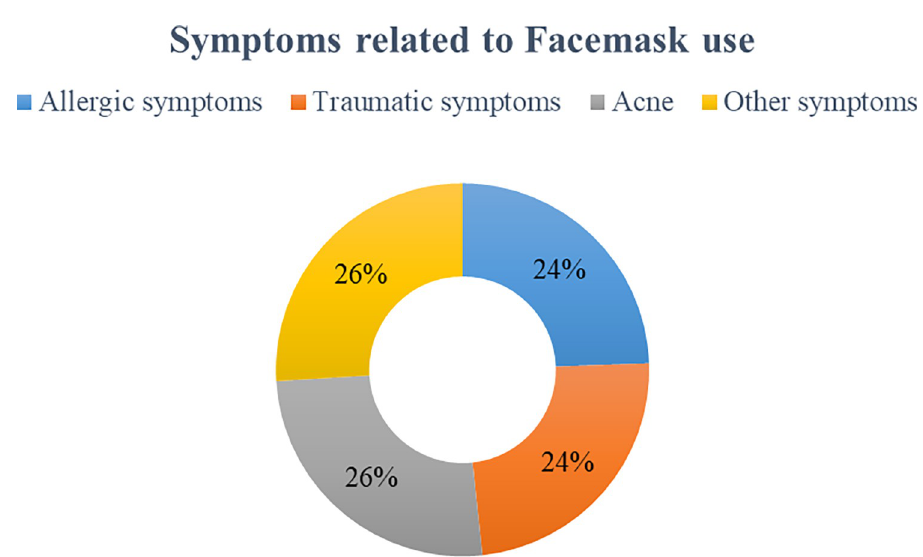
Fig 1. Prevalence of different dermatological symptoms due to facemask